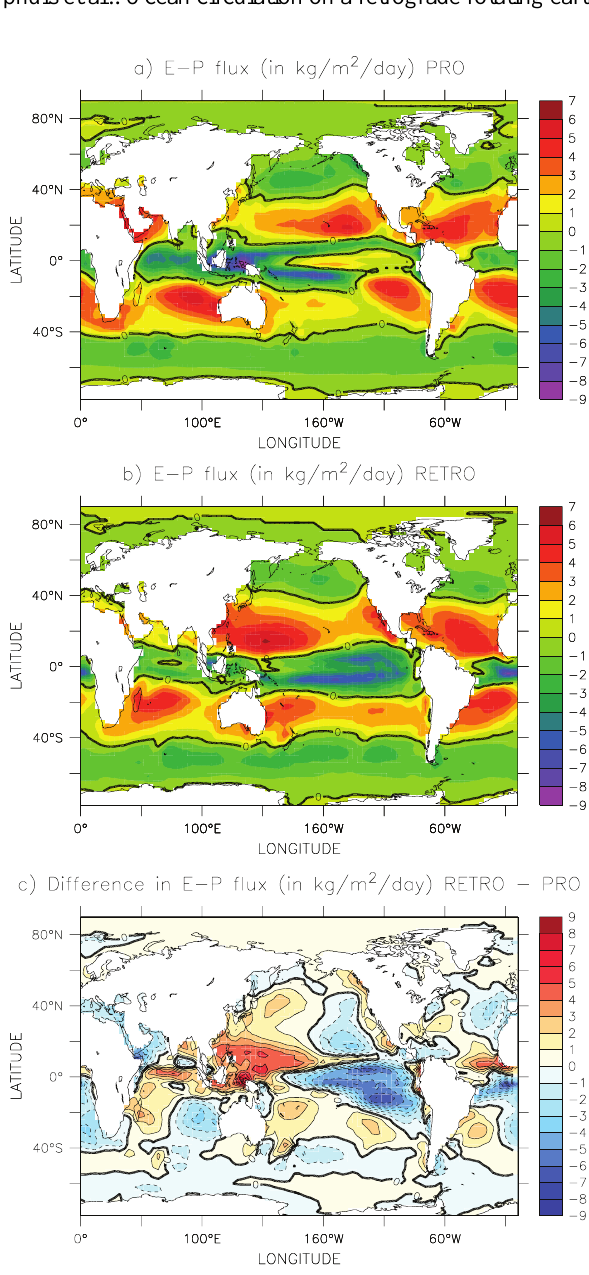
Fig. 7. The virtual salt flux (in kgm − 2 day − 1 ), corresponding with the surface freshwater flux E − P , in (a) PRO; (b) RETRO and (c) the difference field. In RETRO, the asymmetry in E − P is reversed, mainly due to a decrease in net precipitation at subpolar latitudes and an increase in net evaporation at subtropical